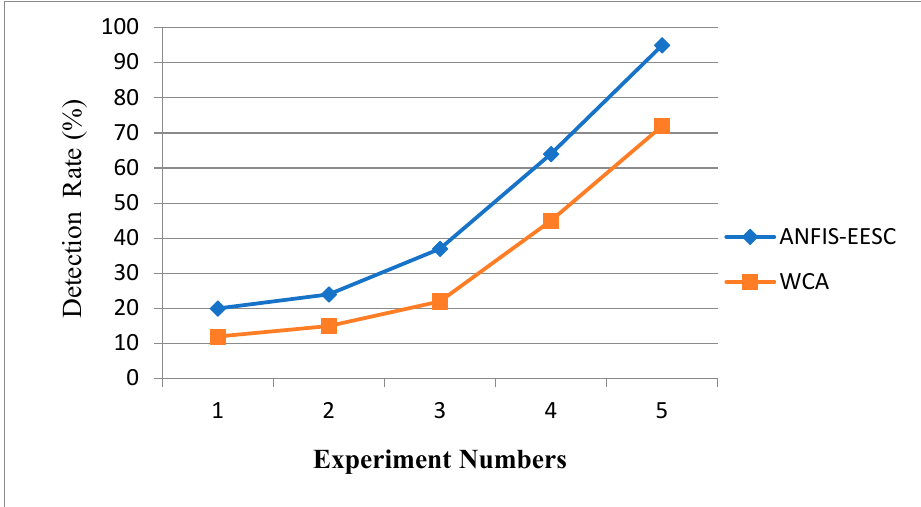
Figure 2. Detection accuracy rate.